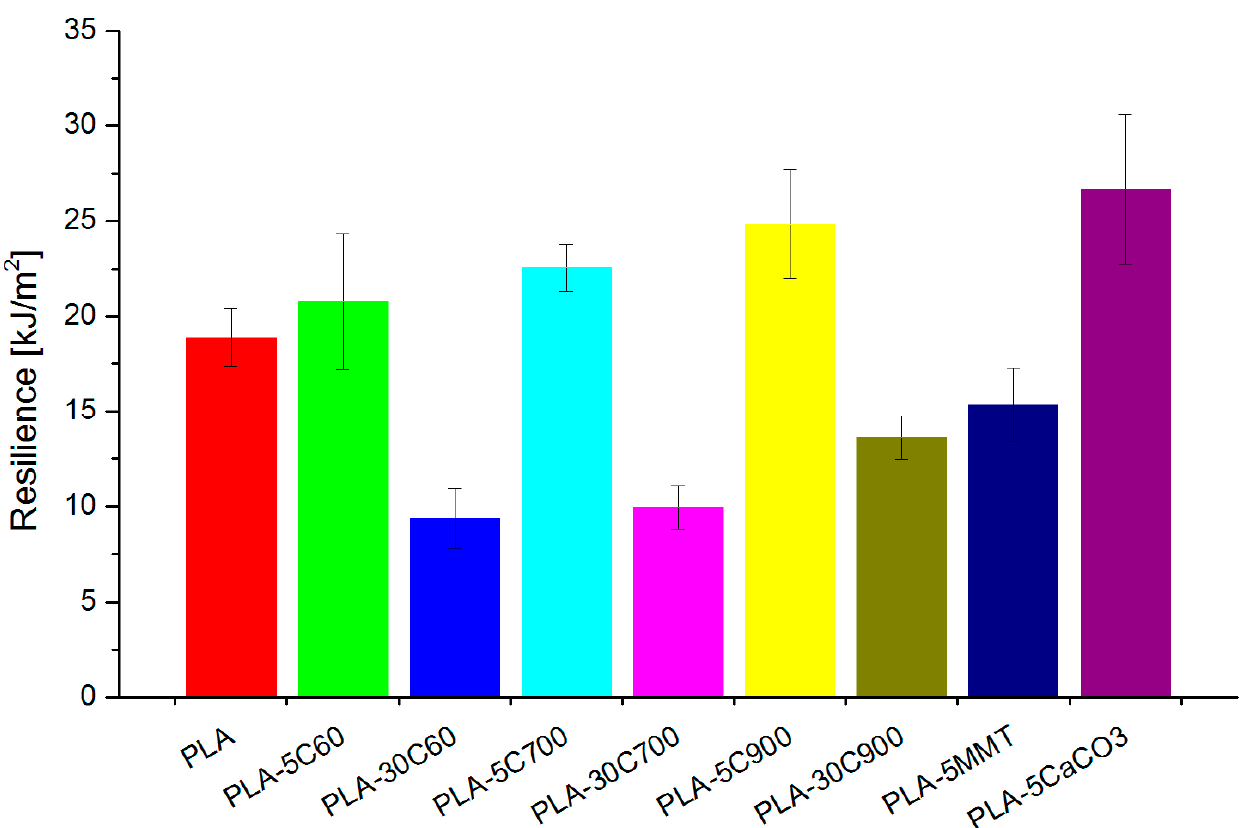
Figure 9. Charpy impact measured for all investigated samples.